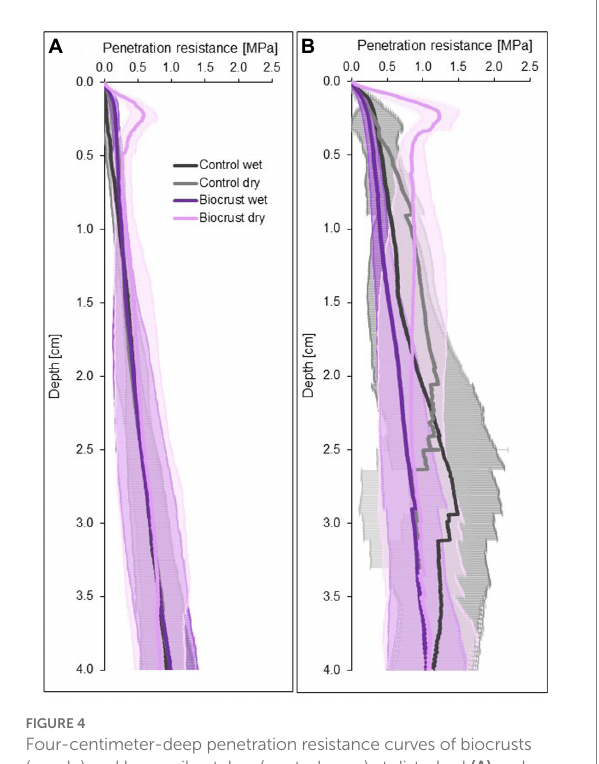
FIGURE 4 Four-centimeter-deep penetration resistance curves of biocrusts (purple) and bare soil patches (control, grey) at disturbed (A) and regenerating (B) sites in the Caatinga dry forest, NE Brazil. Penetration resistance was measured under field dry and wet (water content 0.10 m 3 m -3 ) soil conditions. Lines represent mean penetration resistance values ( n = 10 for disturbed and n = 8 for regenerating site for biocrusts and control soils each), while antennas represent standard